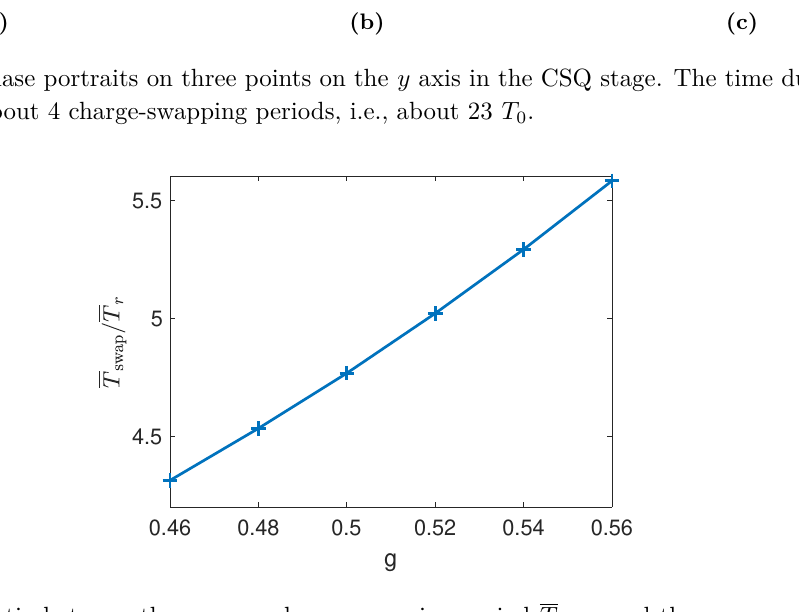
Figure 14. Ratio between the average charge-swapping period T swap and the average oscillation period T of the real component of the field for different coupling constant g . Note that the average r oscillation period T is very close to dominant oscillation period of the real component. r